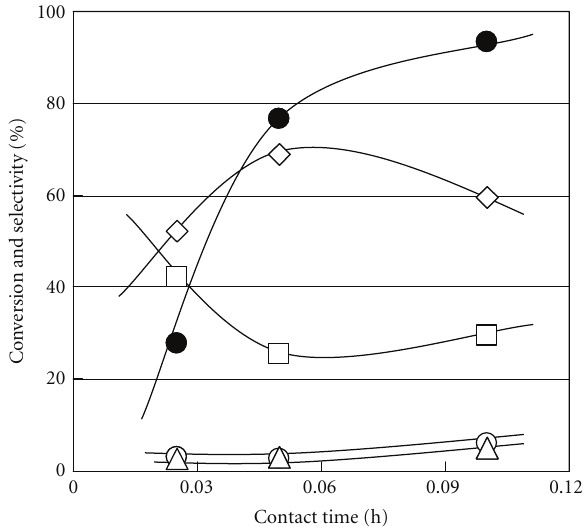
Figure 10: Conversion and product selectivity of catalytic cracking of hydrotreated oil over ns Al 2 O 3 /H-GaAlMFI catalyst depending on contact time. (cid:2) : Conversion; selectivity: (cid:4) : normal para ffi ns; (cid:2) : isopara ffi ns; (cid:2) : olefins; ♦ : aromatics.